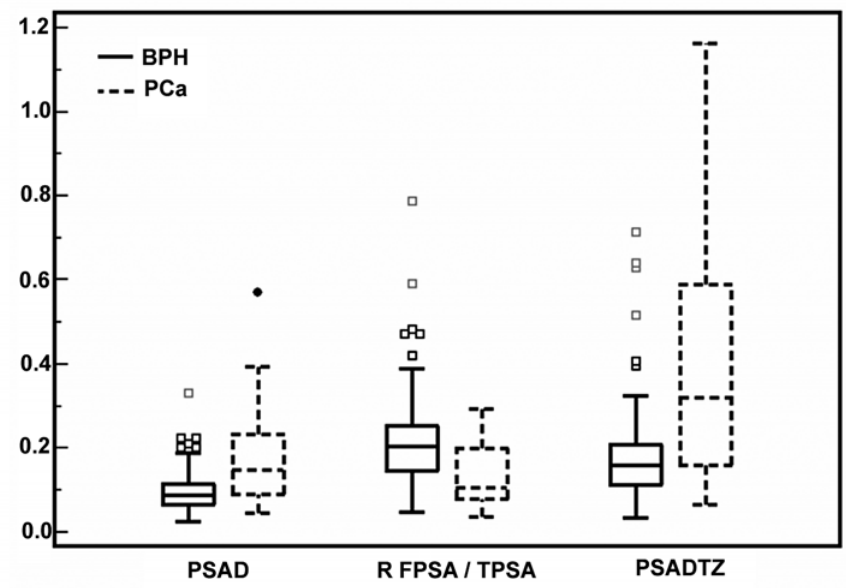
Figure 1 – Box Plot graph showing the PSA density (PSAD) median values distribution in ng/mL/cc, free PSA/ total PSA ratio (RPSALT) and PSA density in the transition zone (PSADTZ) in ng/mL/cc, in patients with prostate cancer (PCa) and benign prostatic hyperplasia (BPH).